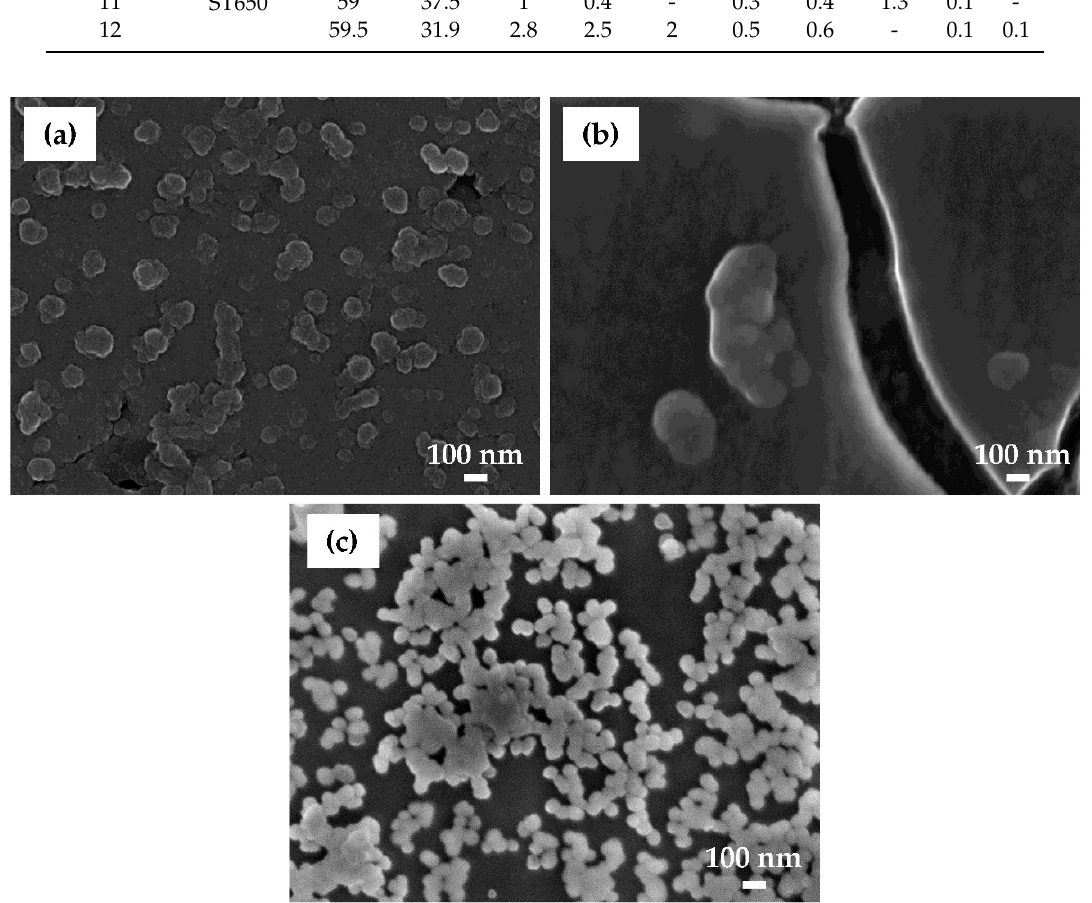
Figure 9. SEM electron secondary electrons micrographs for conversion-coated AA3003 with ST650 coatings of different concentrations: ( a ) 10% ST650; ( b ) 25% ST650 and ( c ) 50% ST650. The conversion time was 18 min at room temperature. Magnification 50.000 × .